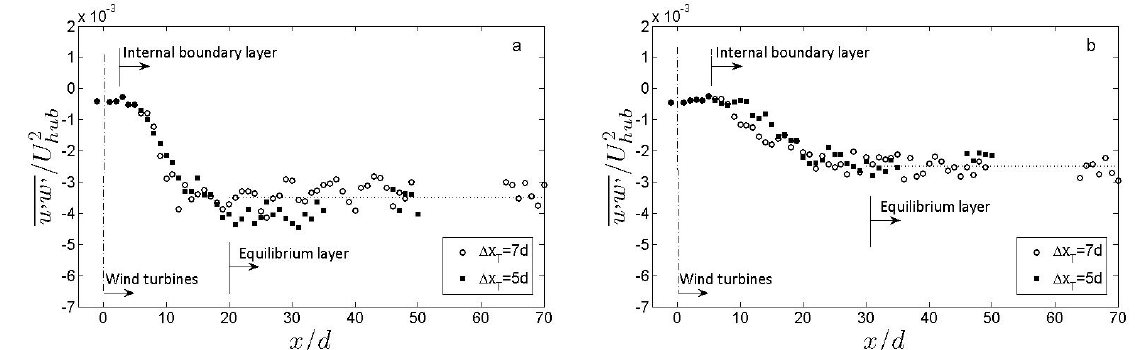
Figure 11. Non-dimensional distribution of kinematic shear stress at different heights above the wind farm. ( a ) z = 1.25 H ; ( b ) z = 1.5 H ; ( c ) z = 2 H . H = turbine